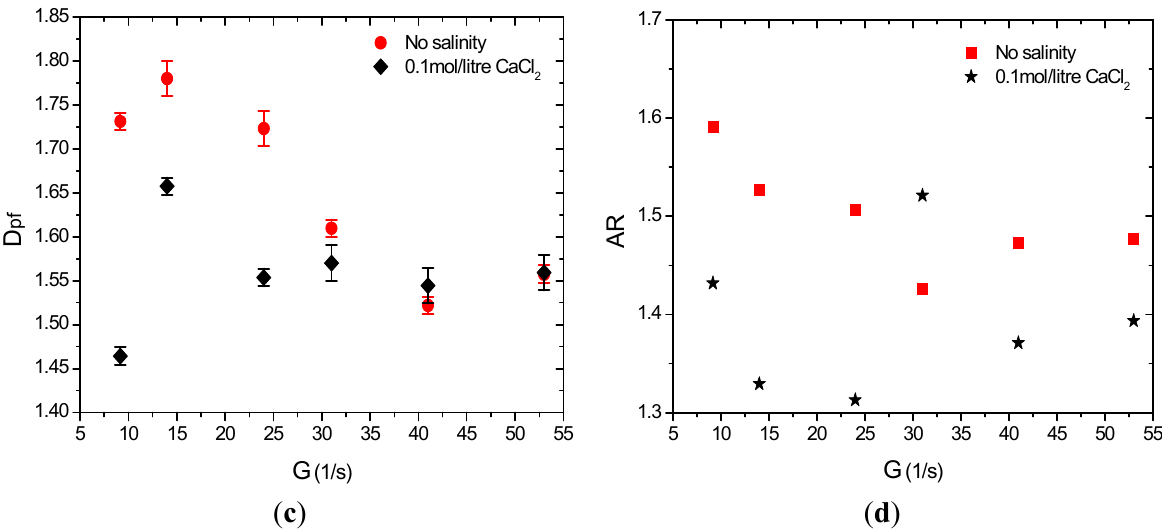
Figure 6. Morphological property parameters of the flocs at steady state over a shear rate range for the non-electrolyte case and the case in which 0.1 mol/L calcium chloride ( CaCl 2 ) was added into the suspension at φ = 7.87 × 10 − 5 , including 2-D fractal dimension ( a ); 1-D fractal dimension ( b ); perimeter-based fractal dimension ( c ) and aspect ratio( d ). The error bars in ( a – c ) show standard deviations of D 2 , D 1 , and D pf values,